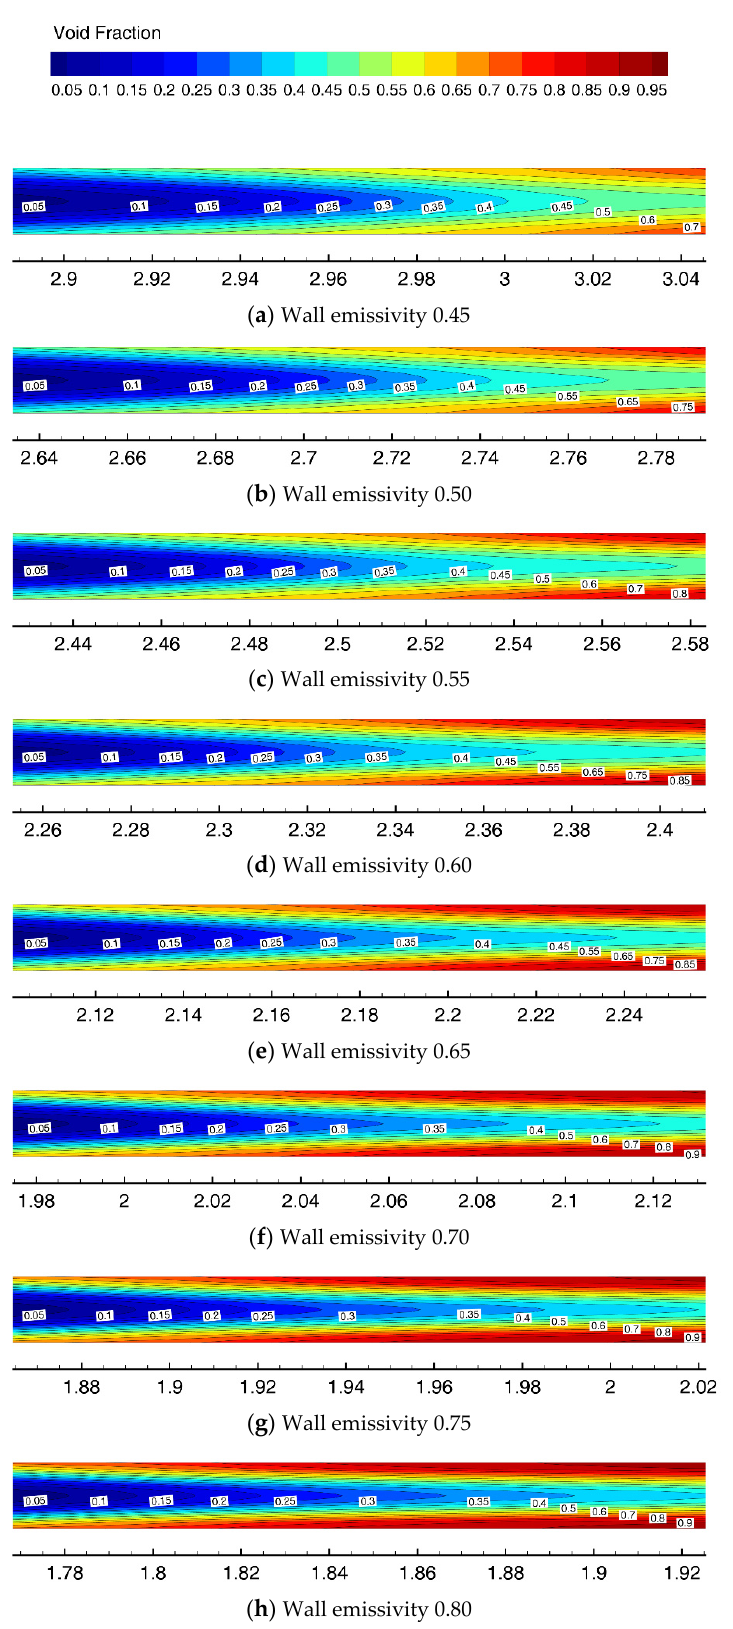
Figure 12. Local void fraction distributions under wall emissivity ranging from 0.40 to 0.80 ( x -axis is the axial distance).